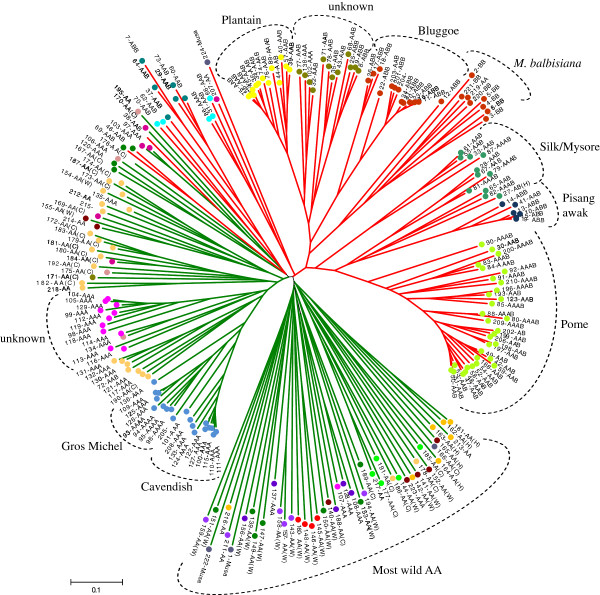
Phenogram demonstrating the genetic relationships among 224 accessions from the ex-situ conservation collection of ‘Embrapa Mandioca Fruticultura’ Center based on 16 SSR loci, obtained using Neighbor-joining clustering from Jaccard dissimilarity index. Genomic composition based on passport data was included. Full circle colors are related to Figure 6. Accessions containing A genome from M. acuminata are shown in green branch line and with B genome from M. balbisina in red branch line.